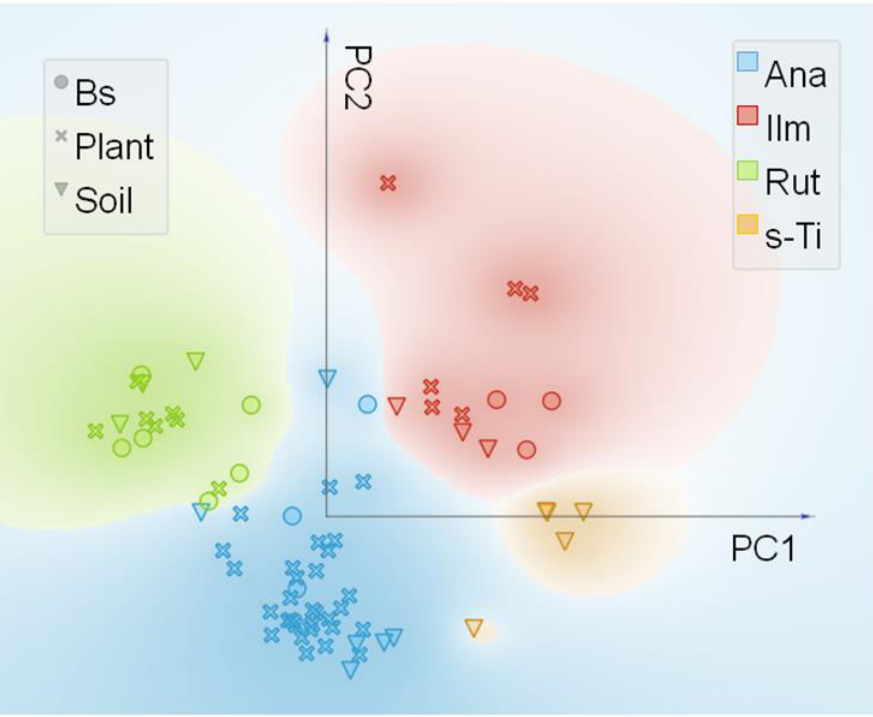
Figure 4. Principal component analysis (PCA) and pre-edge micro X-ray Absorption Near-Edge Structure (µXANES) scatter plot of PC1 vs. PC2 from the experimental µXANES spectra obtained from all plant treatments, biosolid, and soil samples. The colors were attributed to the four main groups achieved and named as Ana (anatase like), Ilm (ilmenite like), Rut (rutile like), and s-Ti (Ti-containing compounds from soil).